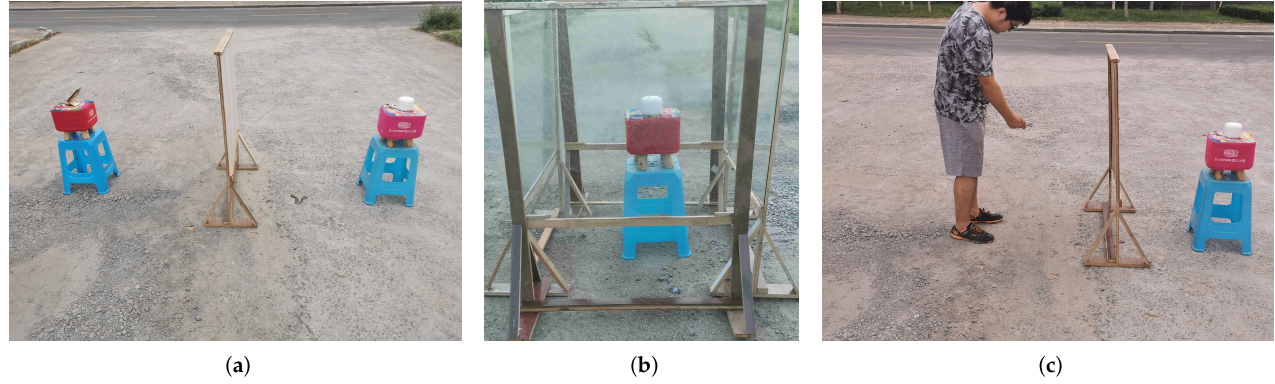
Figure 3. Blockers’ settings in all environments: ( a ) range and position-fixed environment; ( b ) range- fixed and position-varied environment; ( c ) range-varied and position-varied